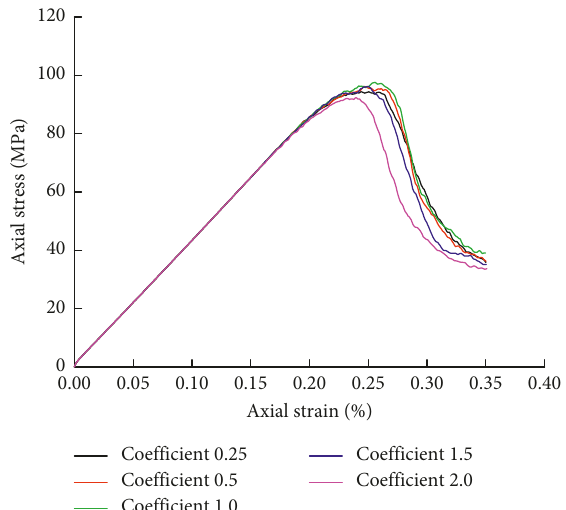
Figure 15: Axial stress-strain curves from uniaxial compression tests for the different coefficients of the friction